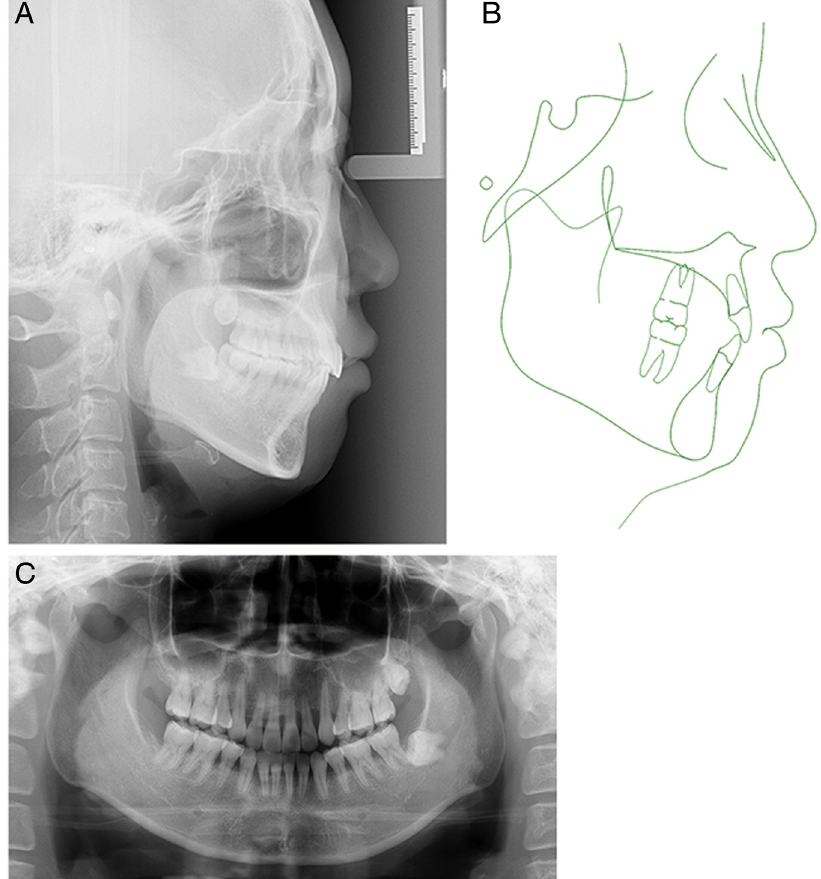
Figure 12. Posttreatment radiographs and tracing: (A) lateral cephalometric radiograph; (B) cephalometric tracing; (C) panoramic